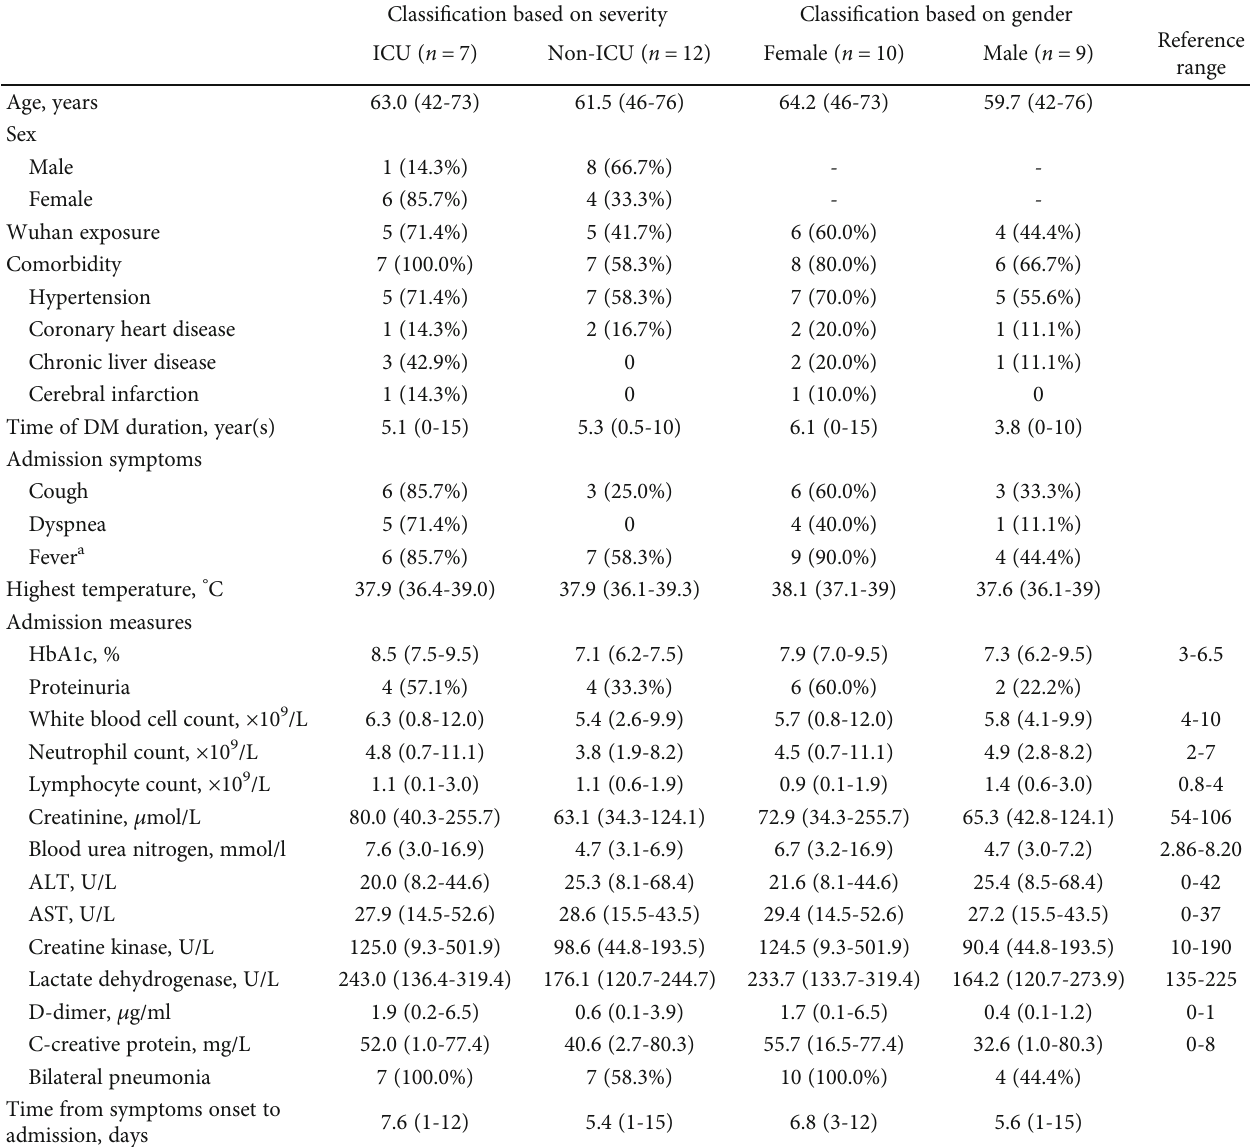
Table 2: Clinical characteristics of DM patients with